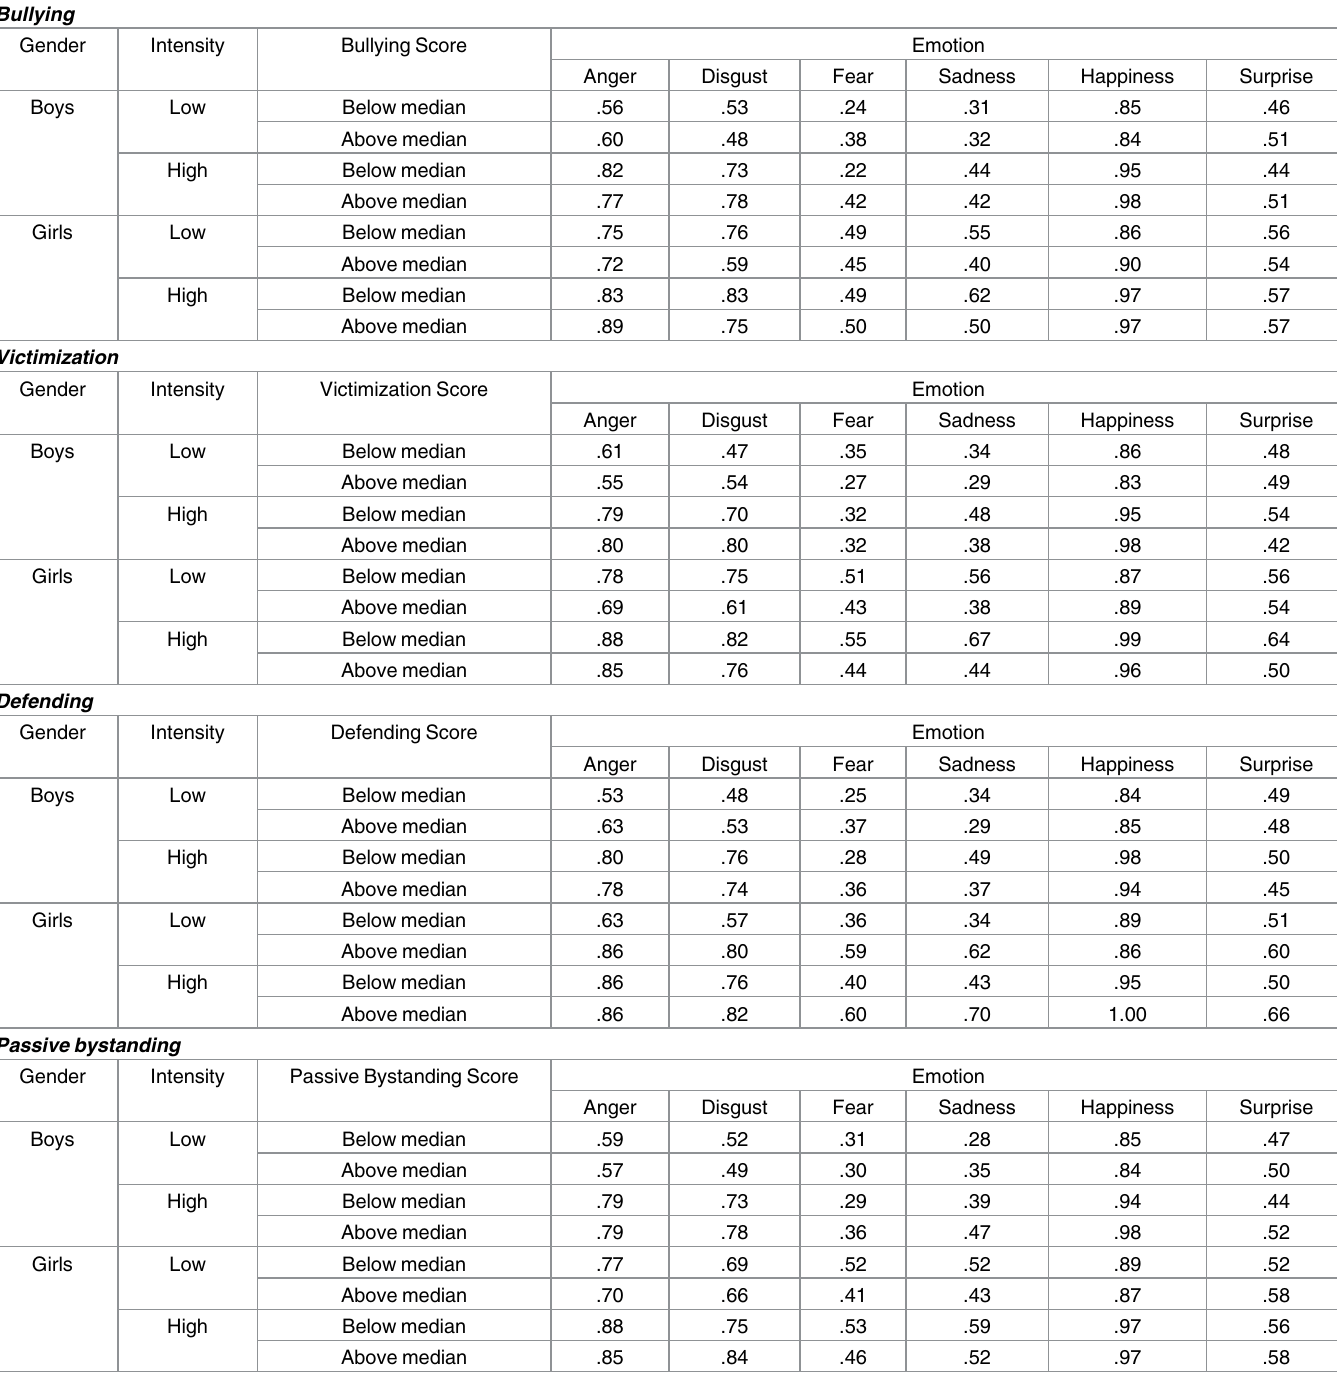
Table 4. Mean proportion of accuracyin emotion recognition by intensity, emotion, gender and behaviors during bullying episodes (i.e., bullying/ /victimization/ defending/passive bystanding score). Medianswere calculatedseparately for boys and girls. Bullying Gender Intensity Bullying Score Emotion Anger Disgust Fear Sadness Happiness Surprise Boys Low Below median .56 .53 .24 .31 .85 .46 Above median .60 .48 .38 .32 .84 .51 High Below median .82 .73 .22 .44 .95 .44 Above median .77 .78 .42 .42 .98 .51 Girls Low Below median .75 .76 .49 .55 Above median .72 High Below median .83 .83 Above median .89 Victimization Gender Intensity Victimization Score Emotion Below median .61 Above median .55 High Below median .79 .70 .32 Above median .80 .80 .32 Girls Low Below median .78 .75 .51 .56 .87 .56 Above median .69 .61 .43 .38 .89 .54 High Below median .88 .82 .55 .67 .99 .64 Above median .85 .76 .44 .44 .96 .50 Defending Gender Intensity Defending Score Emotion Anger Disgust Fear Sadness Happiness Surprise Below median .53 .48 .25 Above